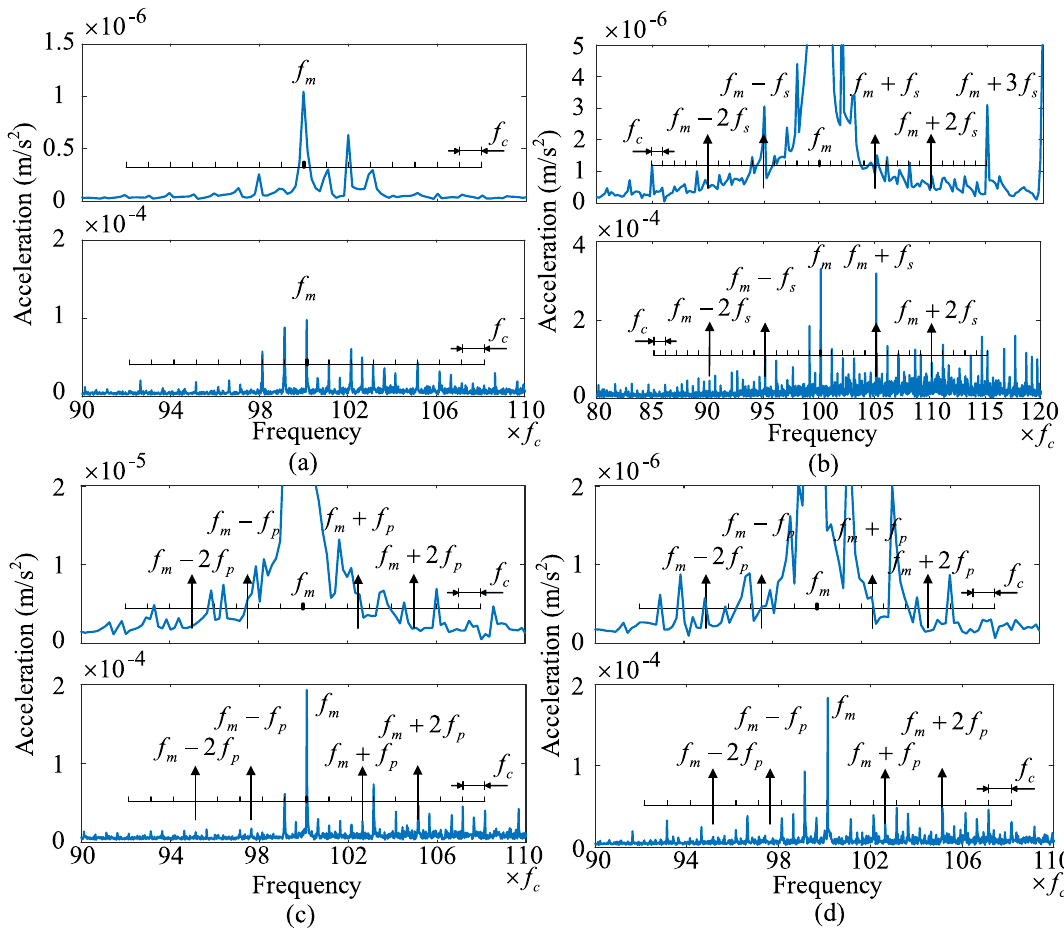
Fig. 6 Frequency spectra of vibration signals from dynamic model (above) and DDS (below). ( a ) NC. ( b ) SWF. ( c ) CTF. ( d )